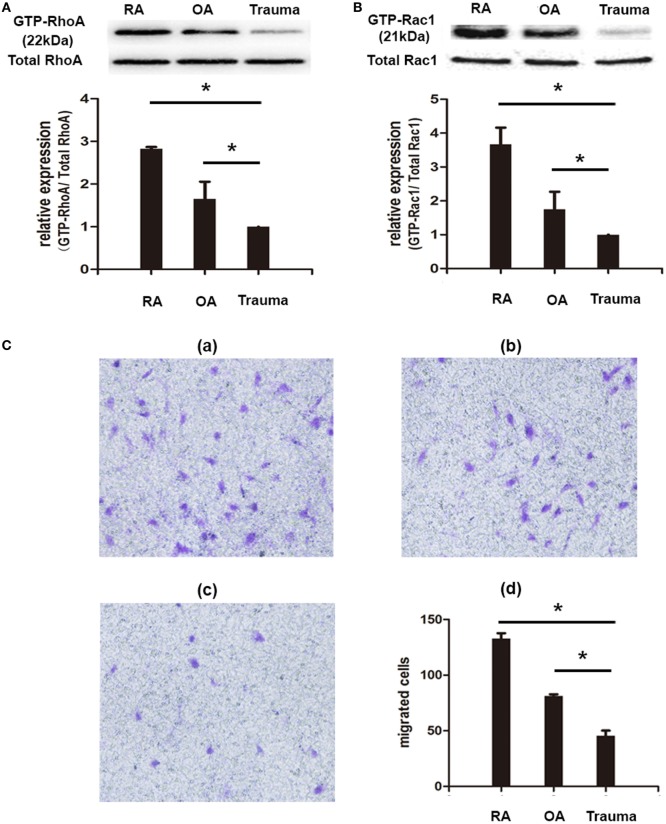
Fibroblast-like synoviocytes (FLSs) from rheumatoid arthritis (RA) patients showed property of migration and activation of Rho GTPase signaling. RA-FLSs, OA-FLSs, and FLSs from patients with knee traumatic injury were isolated and cultured. The activation of RhoA and Rac1 was detected by pull-down assays (A,B). Cell migration was evaluated using Transwell assays and the numbers of migrated cells were calculated (×104 cells/ml) [(C), d] and representative images of migrated cells in RA-FLSs [(C), a], OA-FLSs [(C), b], and FLSs from patients of traumatic injury [(C), c] were displayed (100 magnifications). The results represent the Mean ± SD of three independent experiments. *P < 0.05 versus control group.